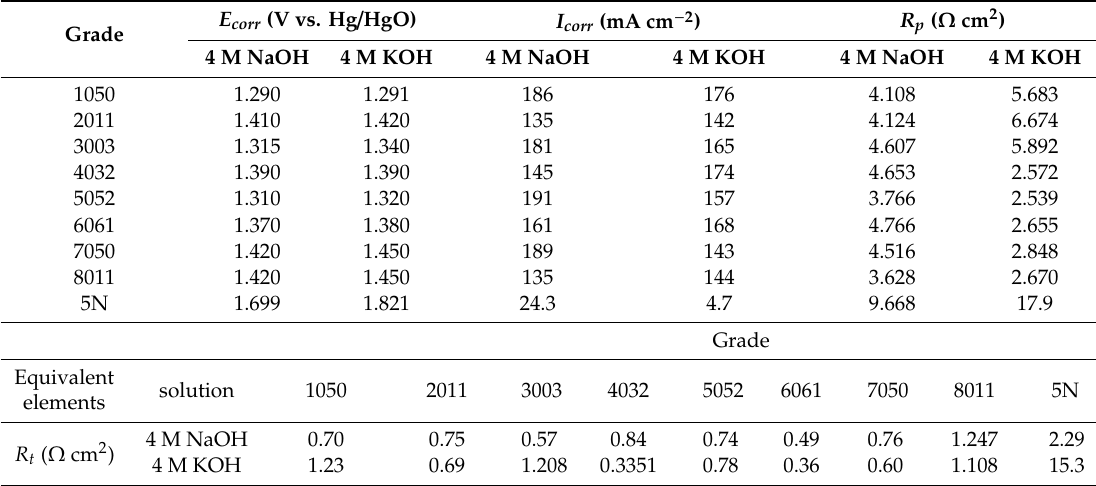
Table 1. Parameters and electrochemical impedance spectroscopy (EIS) value of di ff erent grades of Al anodes